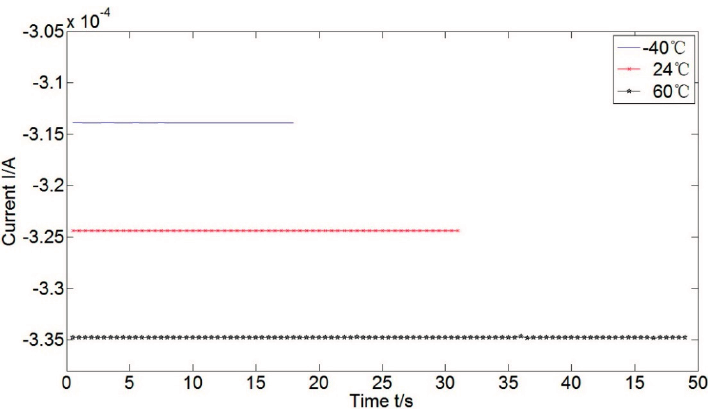
Figure 6. Current outputs of the accelerometer in +g acceleration